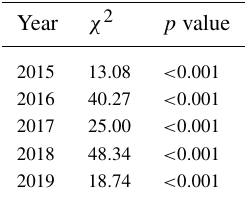
Table 2. The significant differences in GCC between the sites dur- ing the measurement years as a groupwise comparison (Kruskal– Wallis one-way analysis of variance on ranks). χ 2 denotes the chi- squared test